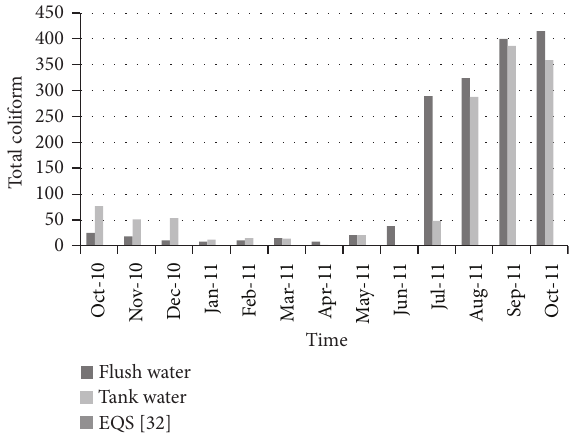
Figure 10: Variation of total coliform over time.